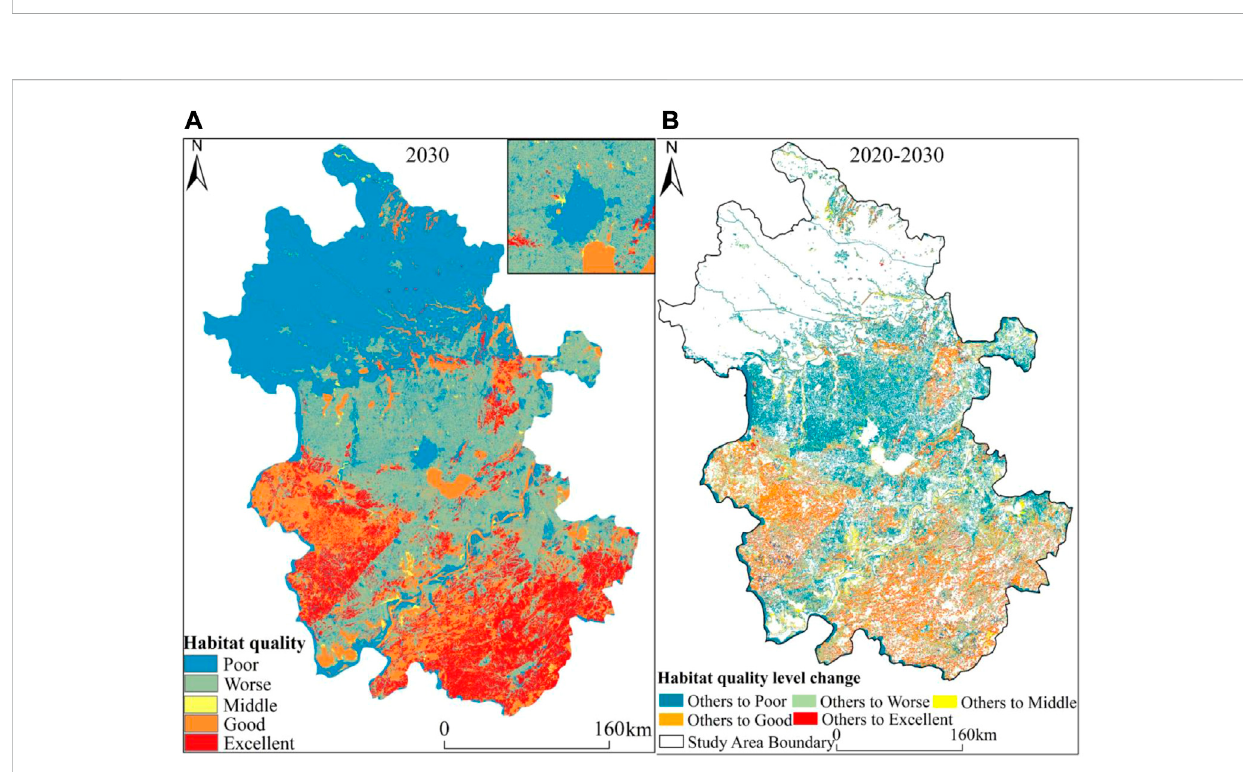
FIGURE 13 (A) Habitat quality in 2030, (B) Habitat quality transfer in the period 2020 –